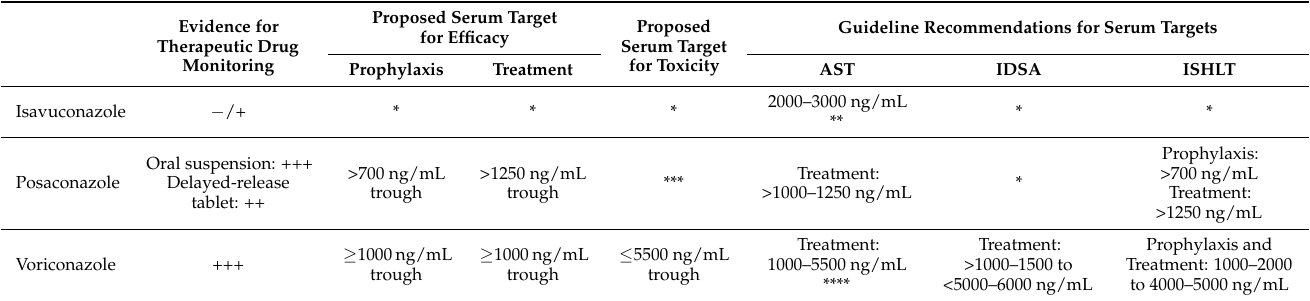
Table 3. Strength of evidence for therapeutic drug monitoring and defined efficacy and toxicity serum targets [3–6,28,33,41,45,77–84]. Evidence for Therapeutic Drug